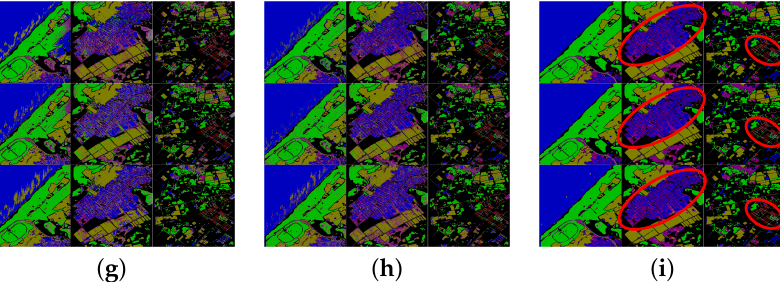
Figure 10. The classification images of the Hainan dataset. In each subfigure, the different columns are the results of the 3 images in the ROI, and the first to third rows are the results of Ka-, C-, and L-band, respectively. ( a ) CNN. ( b ) CV-CNN. ( c ) 3D-CNN. ( d ) SViT. ( e ) CNN-Dilated. ( f ) CV-CNN-Dilated. ( g ) 3D-CNN-Dilated. ( h ) SViT-Larger. ( i ) The proposed method. The areas with significant improve- ment are marked with the red ellipses.